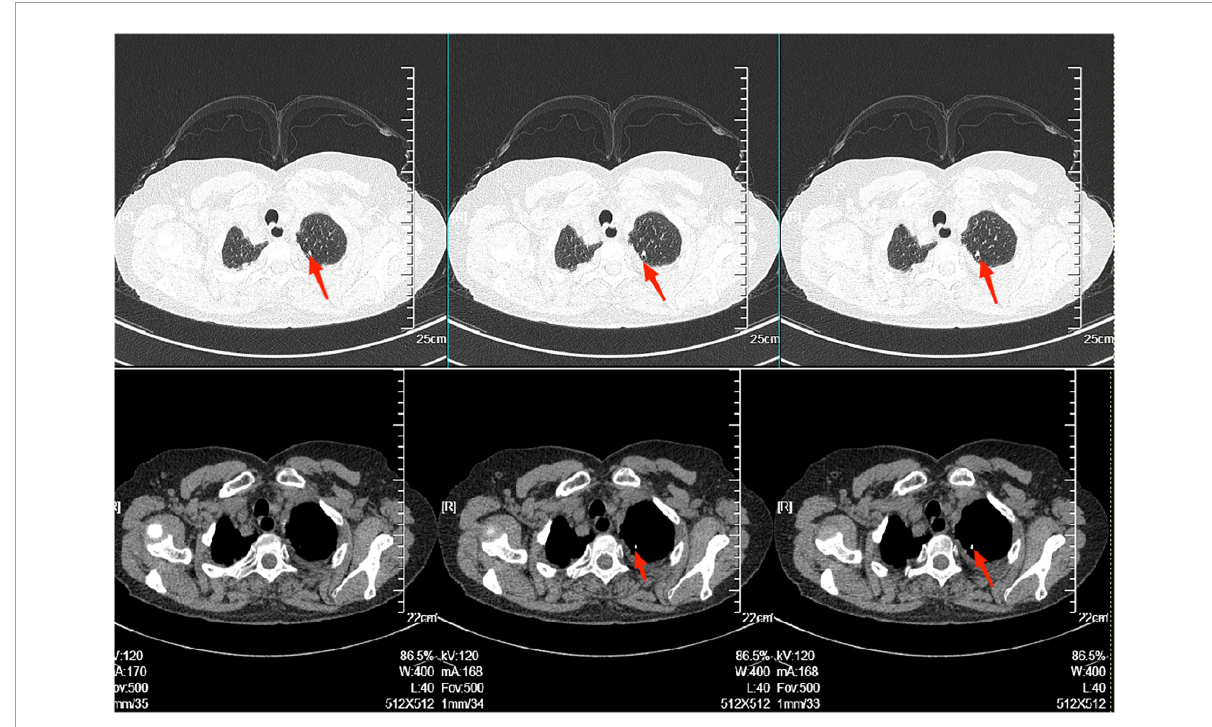
FIGURE3 There was scattered inflammation in both lungs, inflammatory nodules in the upper left and lower right lobes. Calcification in the left upper lobe, as shown in the red arrow in the figure. The radiologist considered it to be stable tuberculosis.